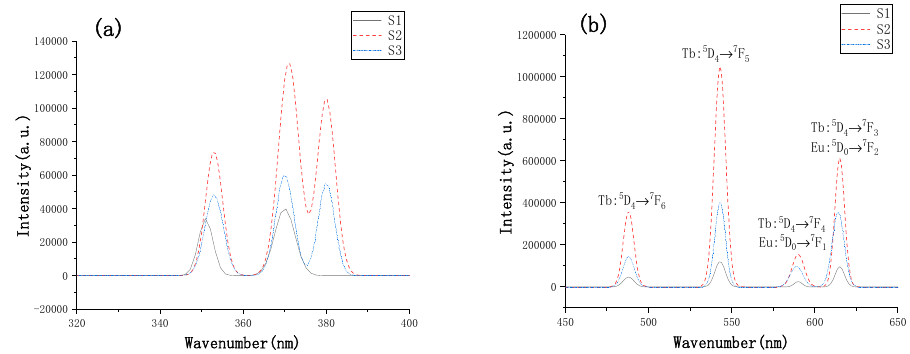
Figure 9. Fluorescence spectra of the blend films: ( a ) excitation spectra, ( b ) emission spectra.